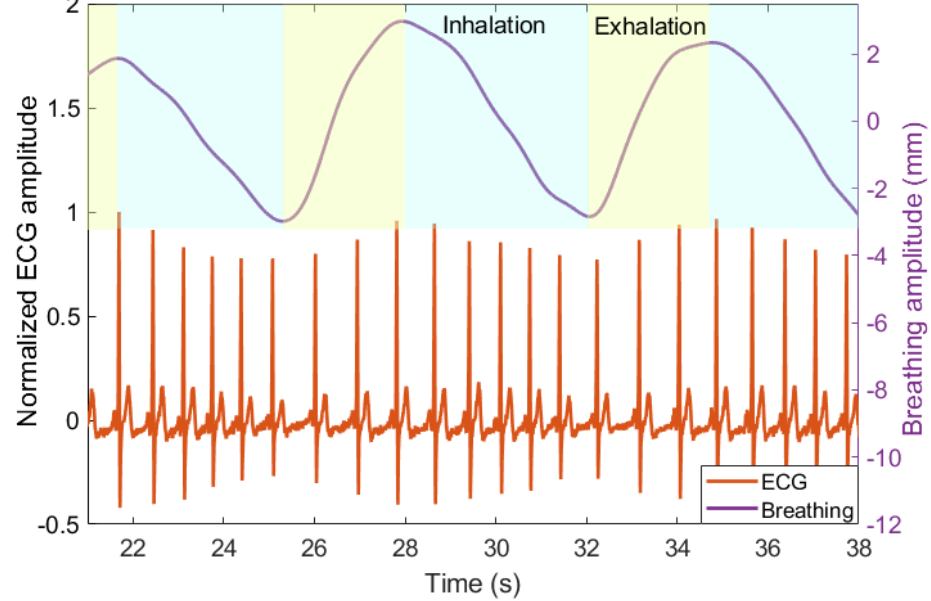
Figure 1. Breathing waveform extracted with the 122 GHz radar setup compared with its ECG